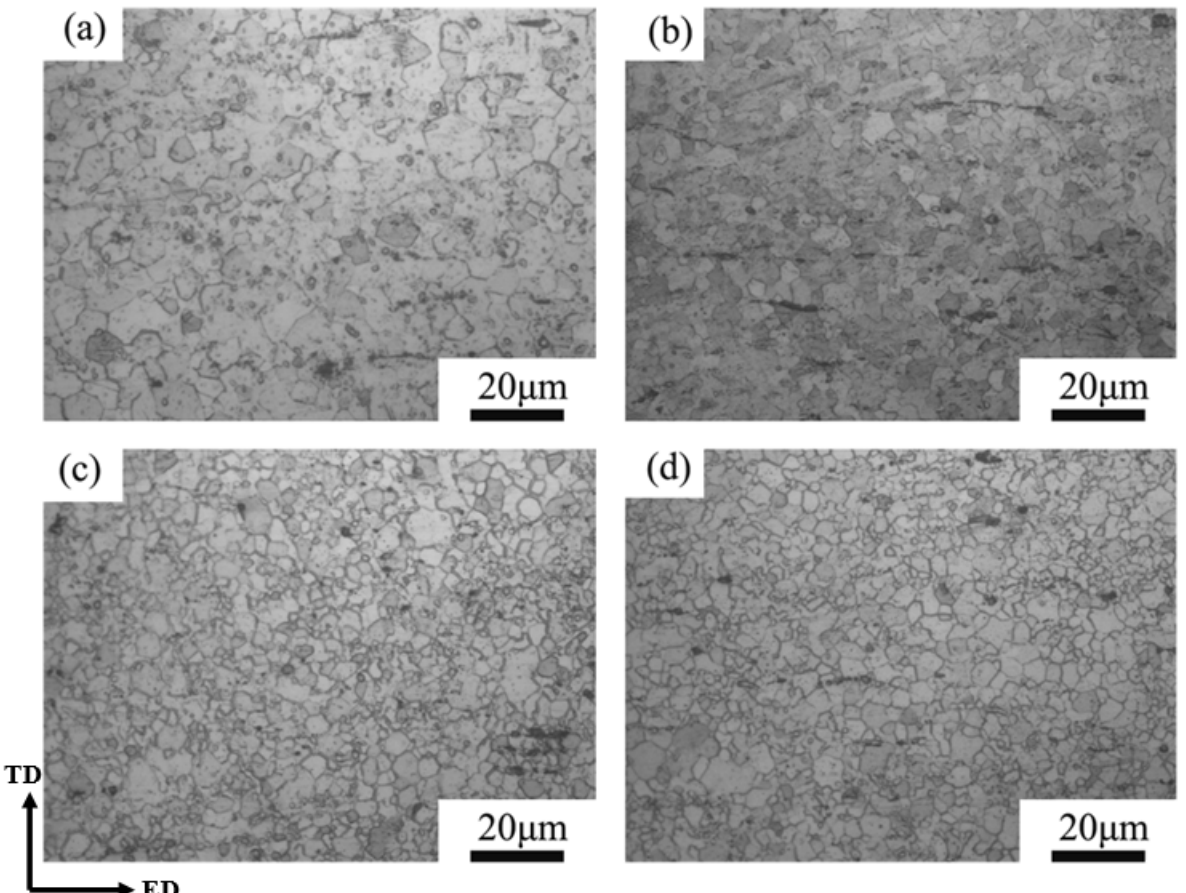
Figure 3. Calculated Mg-2Al-xCa (x, 0–1 wt.%) phase diagram using Pandat.